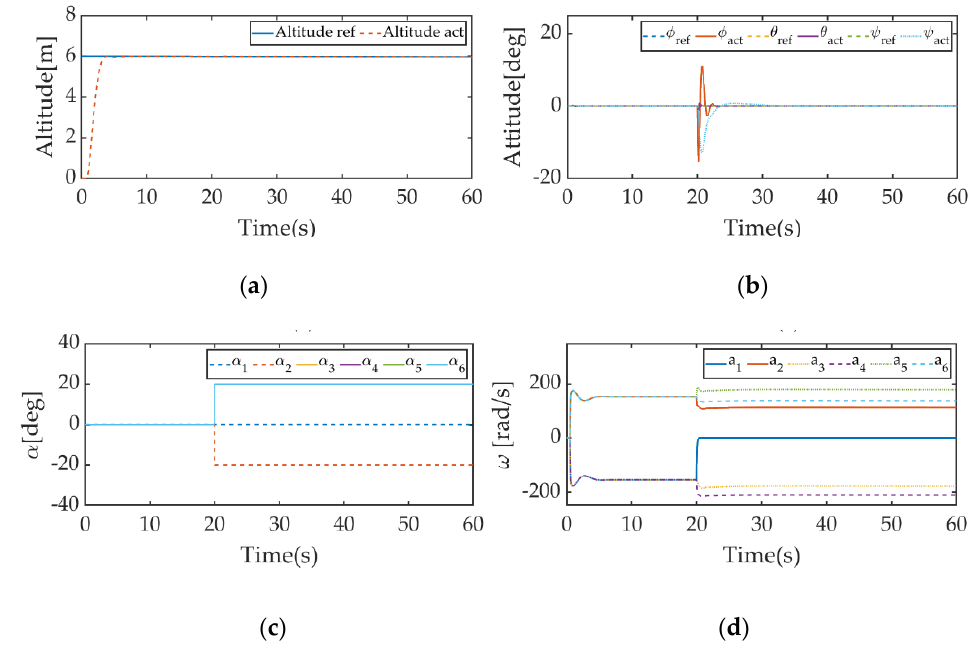
Figure 16. Hovering test result for fault injected at t = 20 s on propeller ( a ) Altitude of the vehicle ( b ) Attitude response ( c ) Propeller tilting angle ( d ) Propeller’s rotation rate.